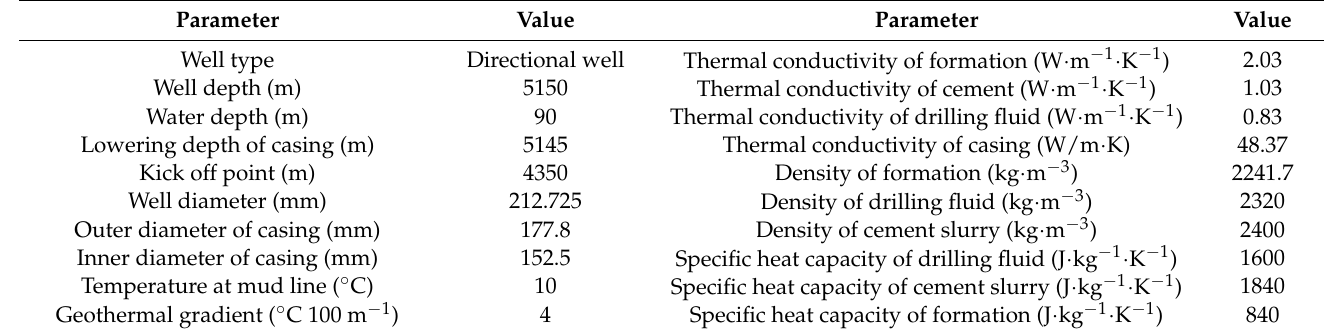
Table 1. Basic parameters of Well X1.